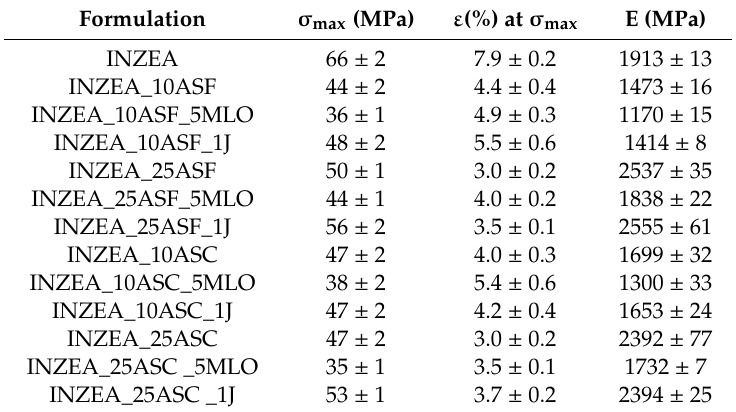
Table 2. Flexural parameters for almond shell powder (ASP)-based biocomposites (mean ± SD, n = 5).